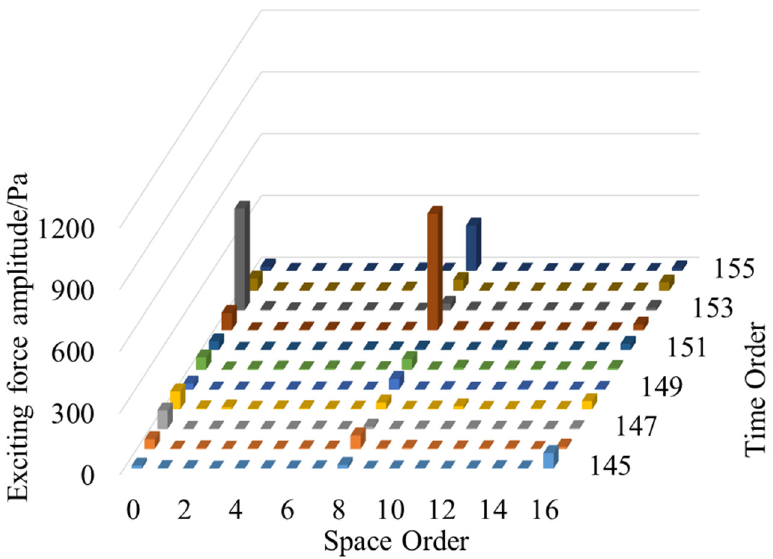
Figure 5. Two-dimensional Fourier decomposition results of the excitation force of the straight slot motors at 1000 rpm .